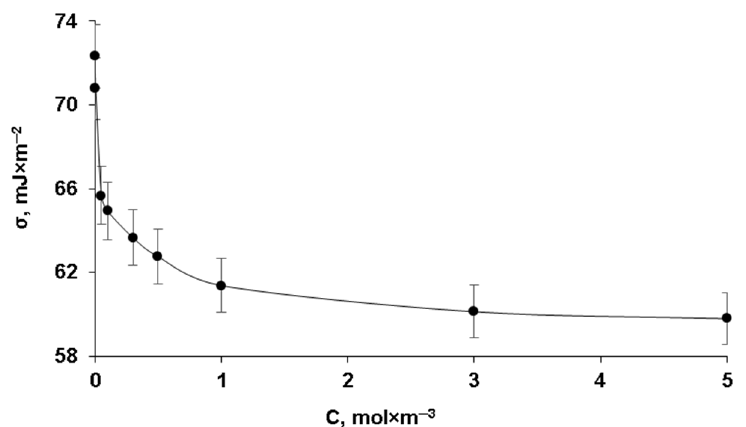
Figure 2. Surface tension isotherm at the water/air interface of the NVPAGE amphiphilic copolymer at a temperature of 298 K.